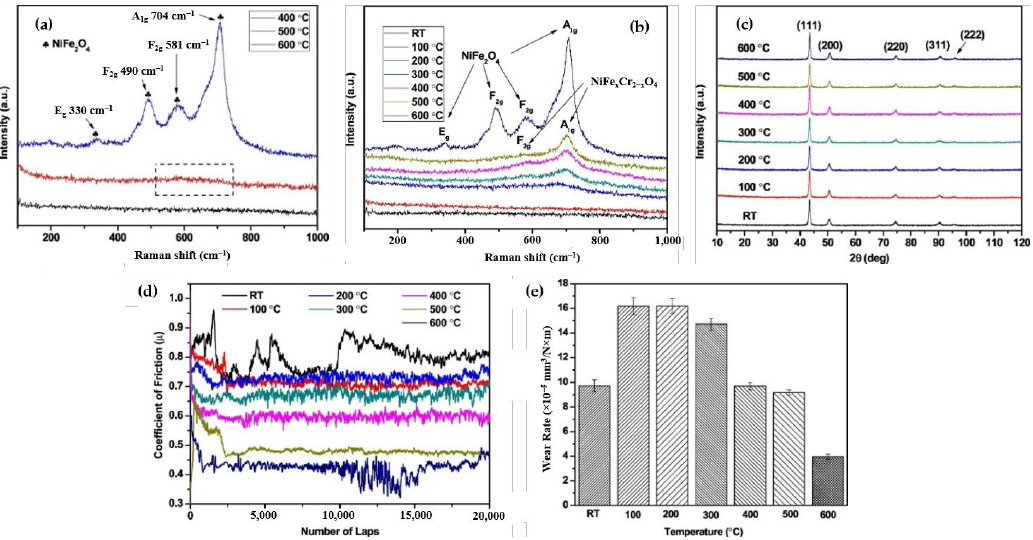
Figure 15. ( a ) Raman spectra of IN718 coatings exposed at different temperatures up to 600 °C, ( b ) Raman spectra of IN718 coatings (after wear tests from low to high temperatures), ( c ) XRD scans of IN718 coatings (in as-sprayed condition and oxidized at different temperatures), and the ( d ) frictional and ( e ) wear responses of CS IN718 in various temperature environments. Reprinted from Sun et al. [109], Copyright 2020, with permission from Elsevier.